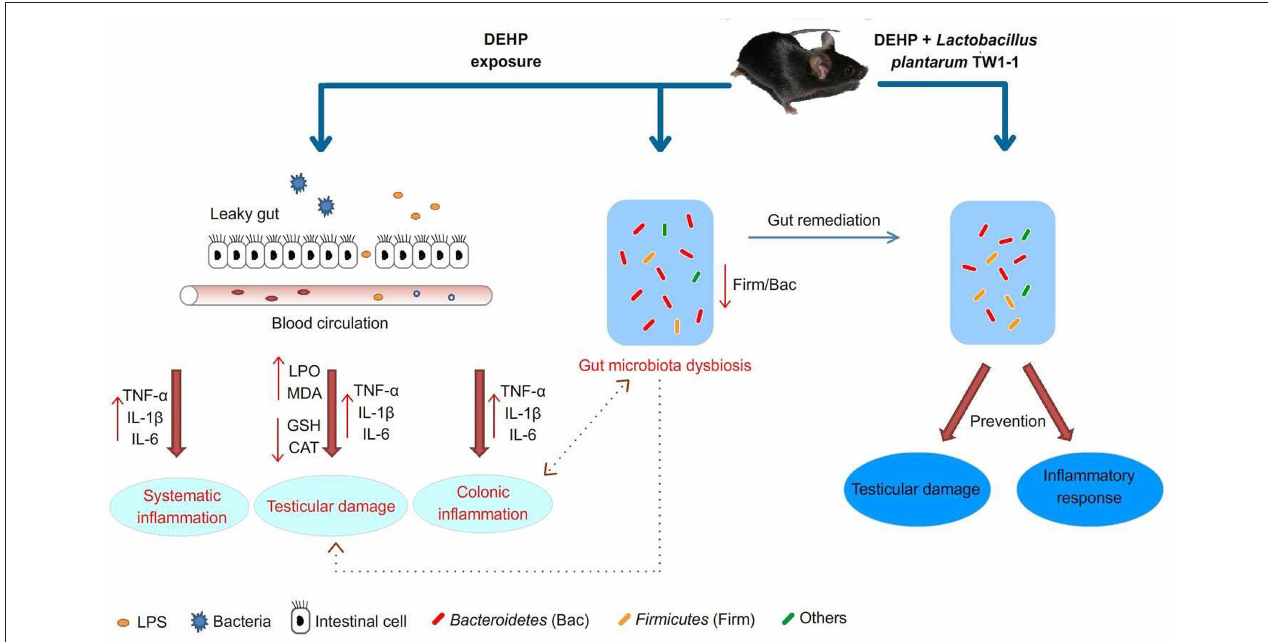
FIGURE 8 | Proposed pathways of protection by L. plantarum TW1-1 treatment against DEHP-induced testicular damage.